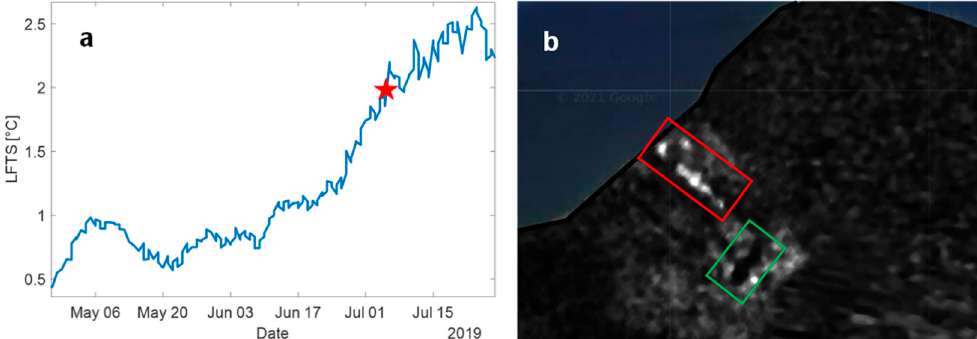
Figure 4. (a) LFTS zoomed in the time interval from May to July 2019. The star highlights the 3 July 2019 paroxysmal event. (b) Change detection image showing explosive deposits and eroded area detected by using the ratio of Sentinel-1 SAR descending images. The amplitude ratio is calculated between the pre-eruptive image of 26 June 2019 and the post-eruptive intensity image of 8 July 2019. The red rectangle indicates the brighter pixels that are related to the biggest materials deposited (widespread pyroclastic density current, ballistics and tephra fallout) during the eruption, whereas the green rectangle indicates the darker pixels related to the removal of materials due to the crater area erosion after the eruption.